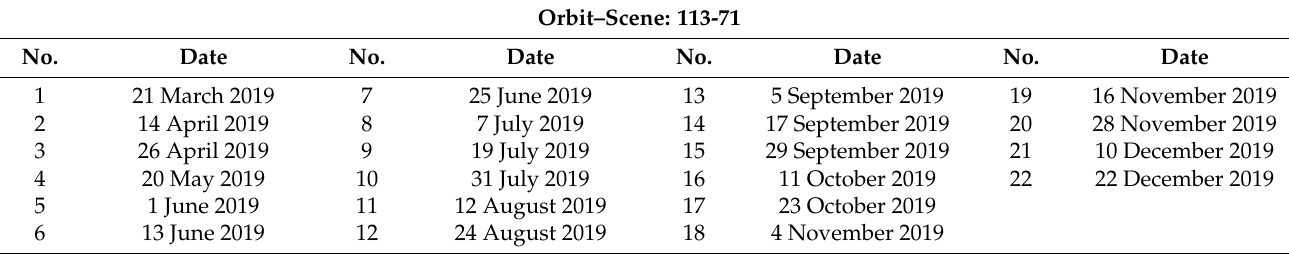
Table 1. List of available SAR data.